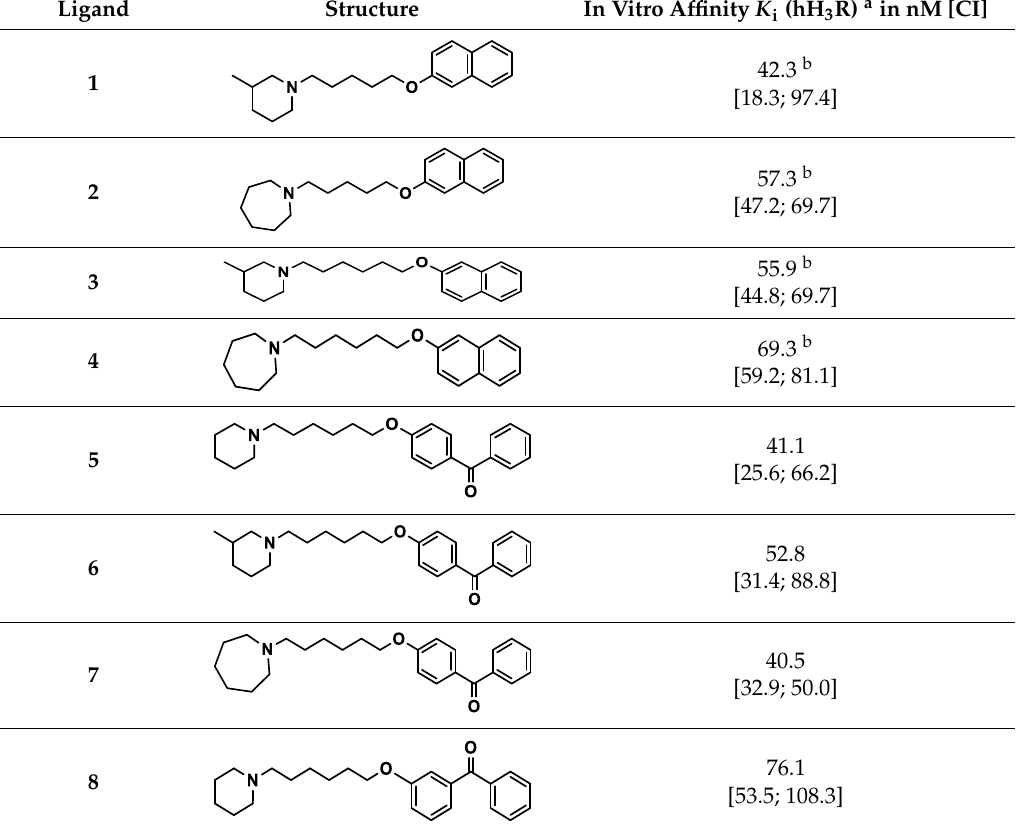
Table 1. In vitro human histamine H3 receptor (hH3R) affinities of ligands 1 – 16 . Ligand Structure